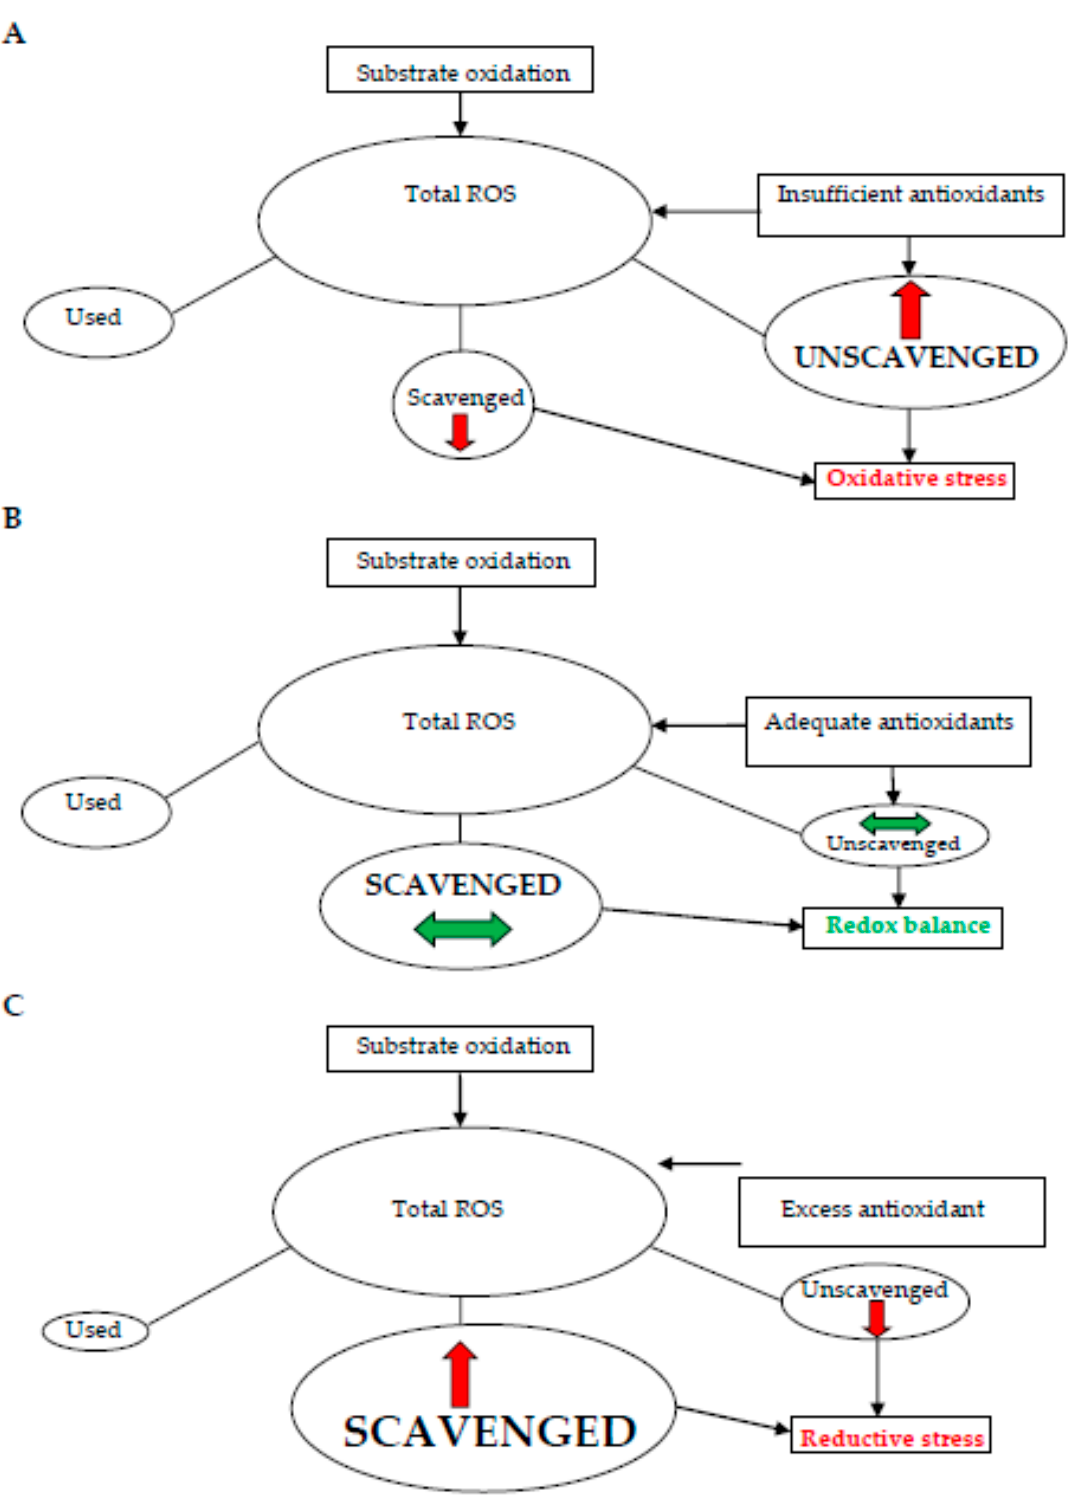
Figure 1. Schematic representation of the cellular redox status under the conditions of oxidative stress ( A ), adequate redox balance ( B ), and reductive stress ( C ).